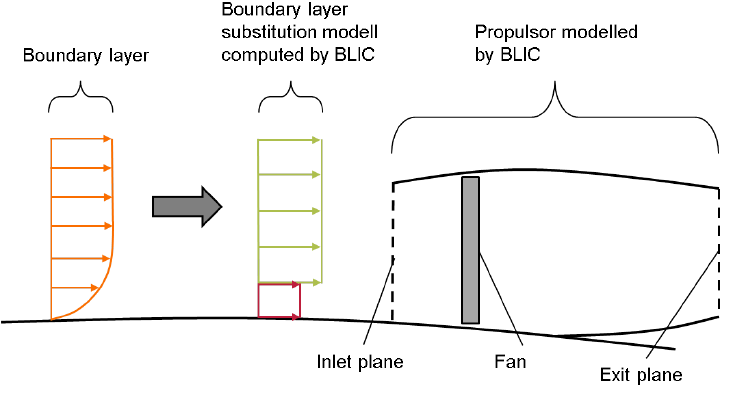
Figure 5. Simulation domain of the BLI calculation